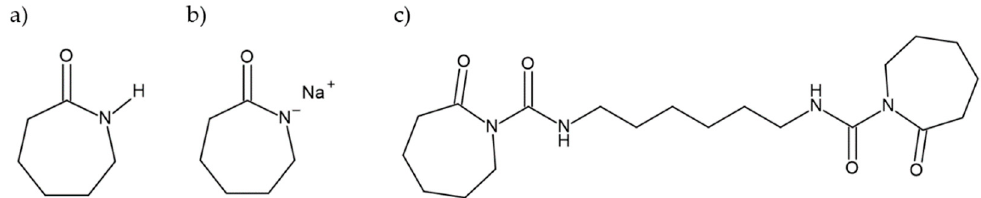
Figure 1. Materials: ( a ) ε -caprolactam (CL), ( b ) sodium caprolactamate (NaCL), ( c ) hexamethylen-1,6-diisocyanate (HDI).